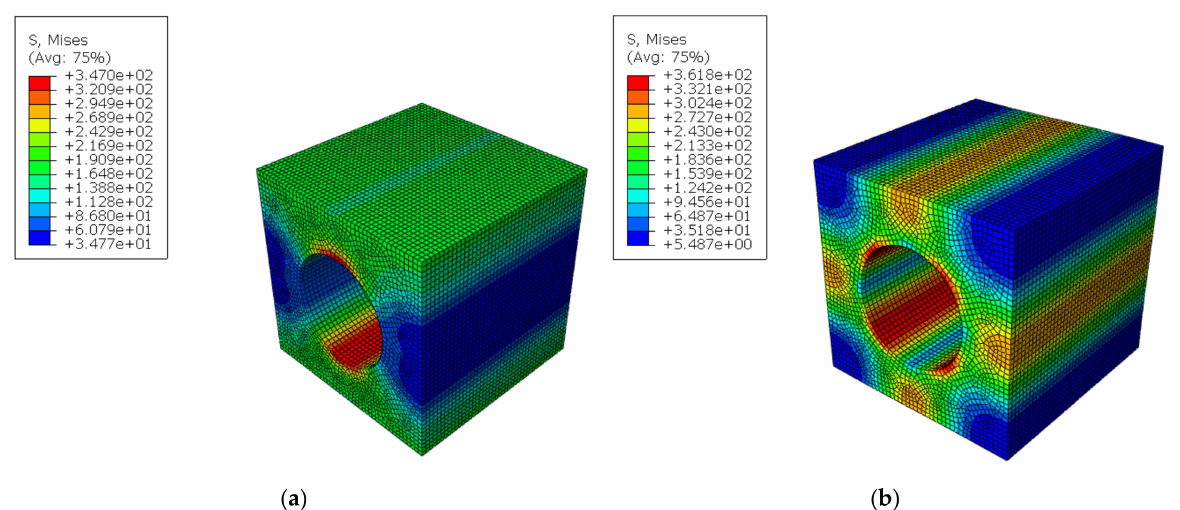
Figure 12. The distribution of stress with 0.1% strain condition. ( a ) X-direction tensile strain. ( b ) XY-direction shear scheme 11. S22, S33, S12, S13 and S23 (S11: tensile stress of X-direction, S22: tensile stress of Y-direction, S33: tensile stress of Z-direction, S12: shear stress of XY-direction, S13: shear stress of XZ-direction, S23: shear stress of YZ-direction) of each element were calculated and printed out. The calculation of weighted average concluded the equivalent stress of each direction at each